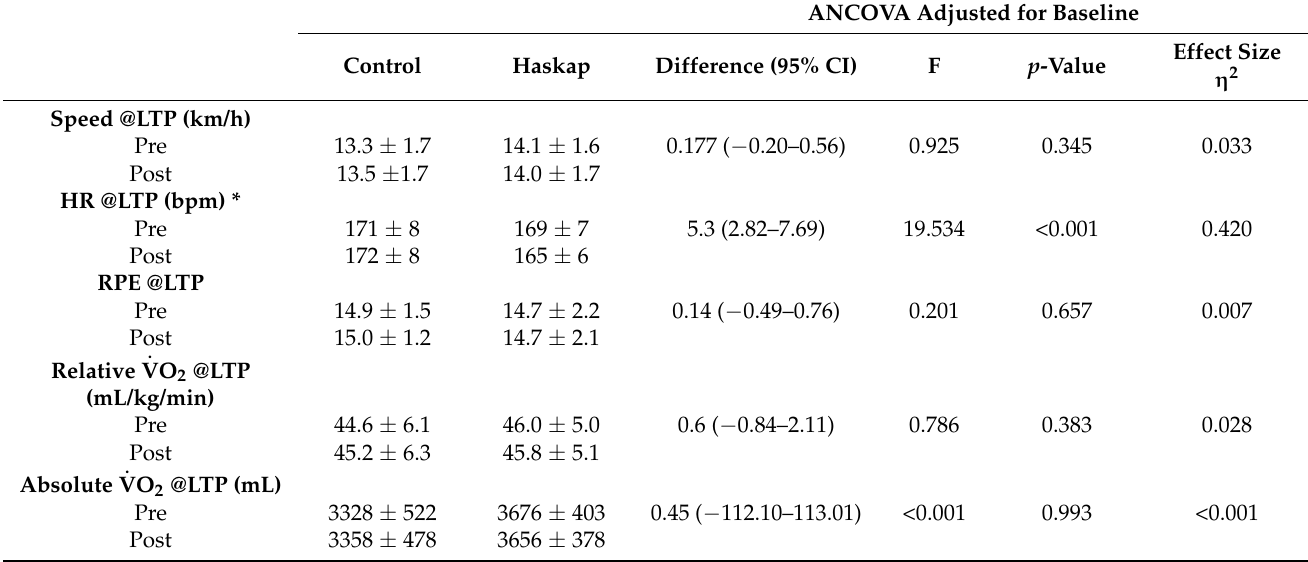
Table 3. Data from the submaximal test for lactate turnpoint (LTP) parameters before and after the intervention of Haskap or placebo control.